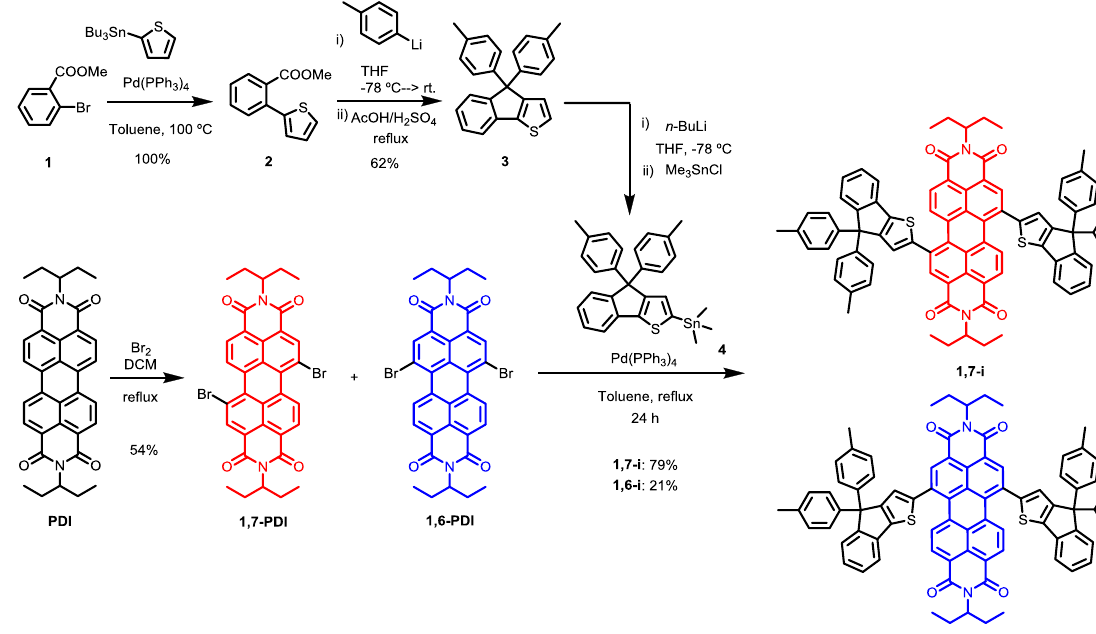
Scheme 1. Synthetic route to 1,6-i and 1,7-i .